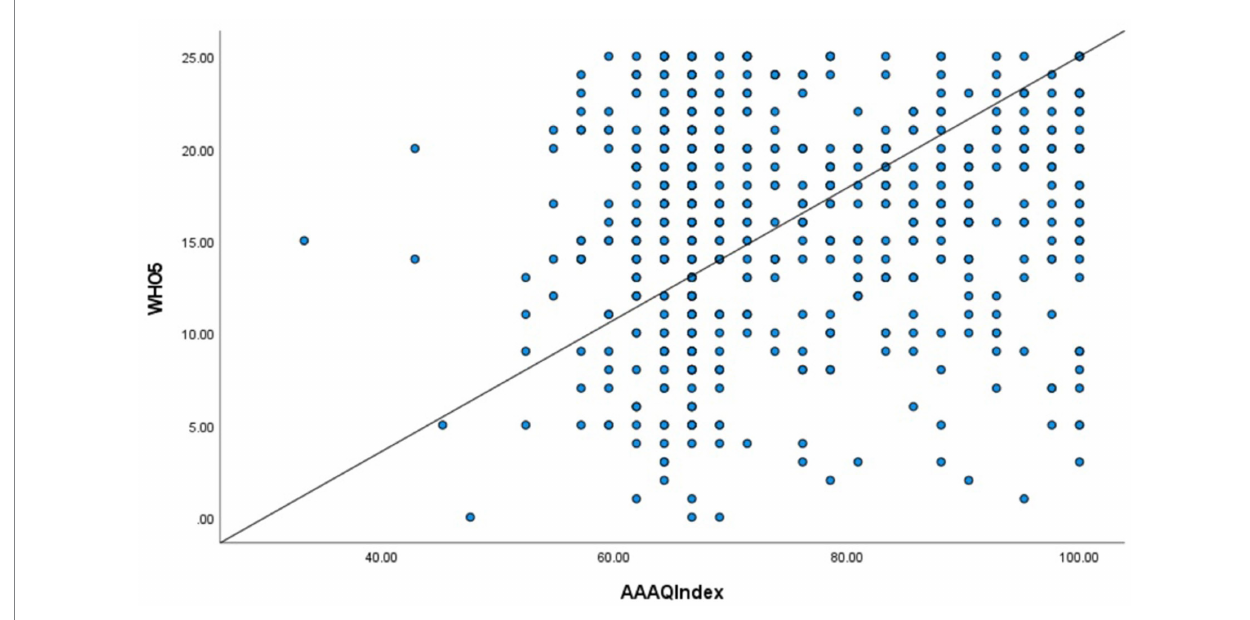
FIGURE 5 Correlation between active aging awareness and well-being